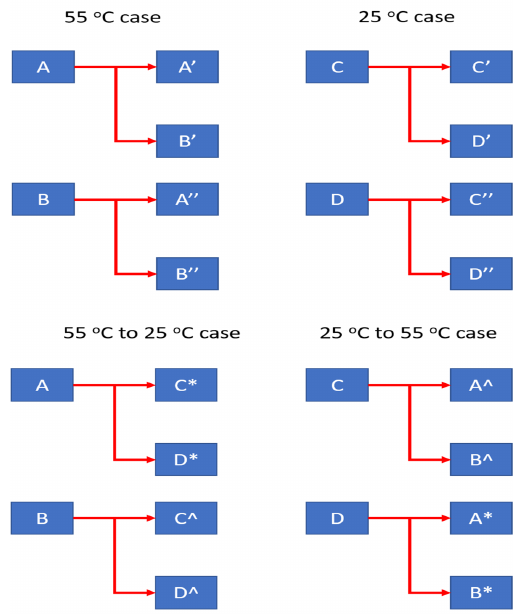
Figure 4. Notations used in the analysis of test results.